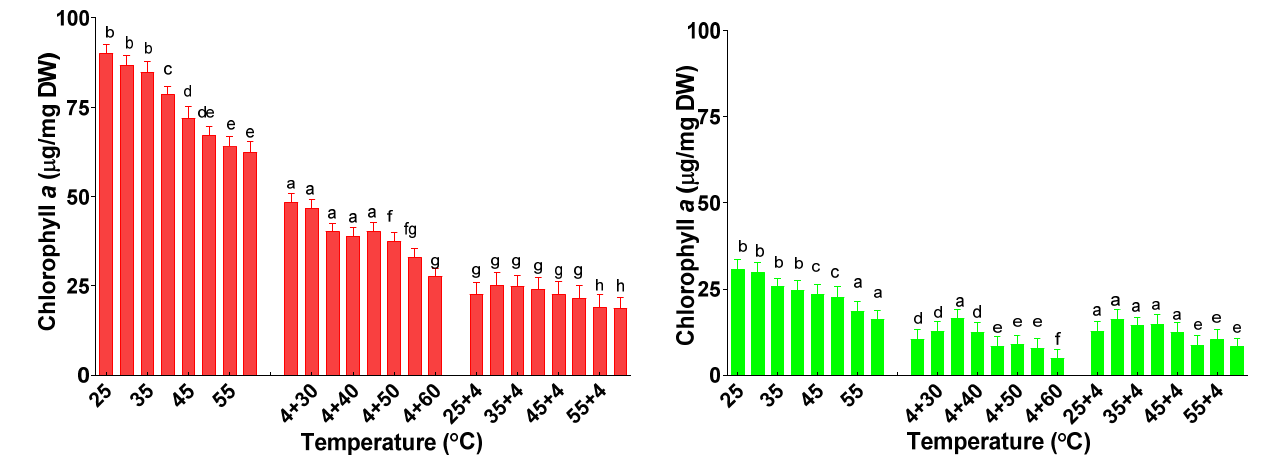
Figure 6. The content of chlorophyll a from basil plants (red) and sage plants (green) was subjected to different treatment temperatures. Data sharing different letters are significantly different ( p < 0.05), while data sharing the same letters are not significantly different ( p > 0.05).